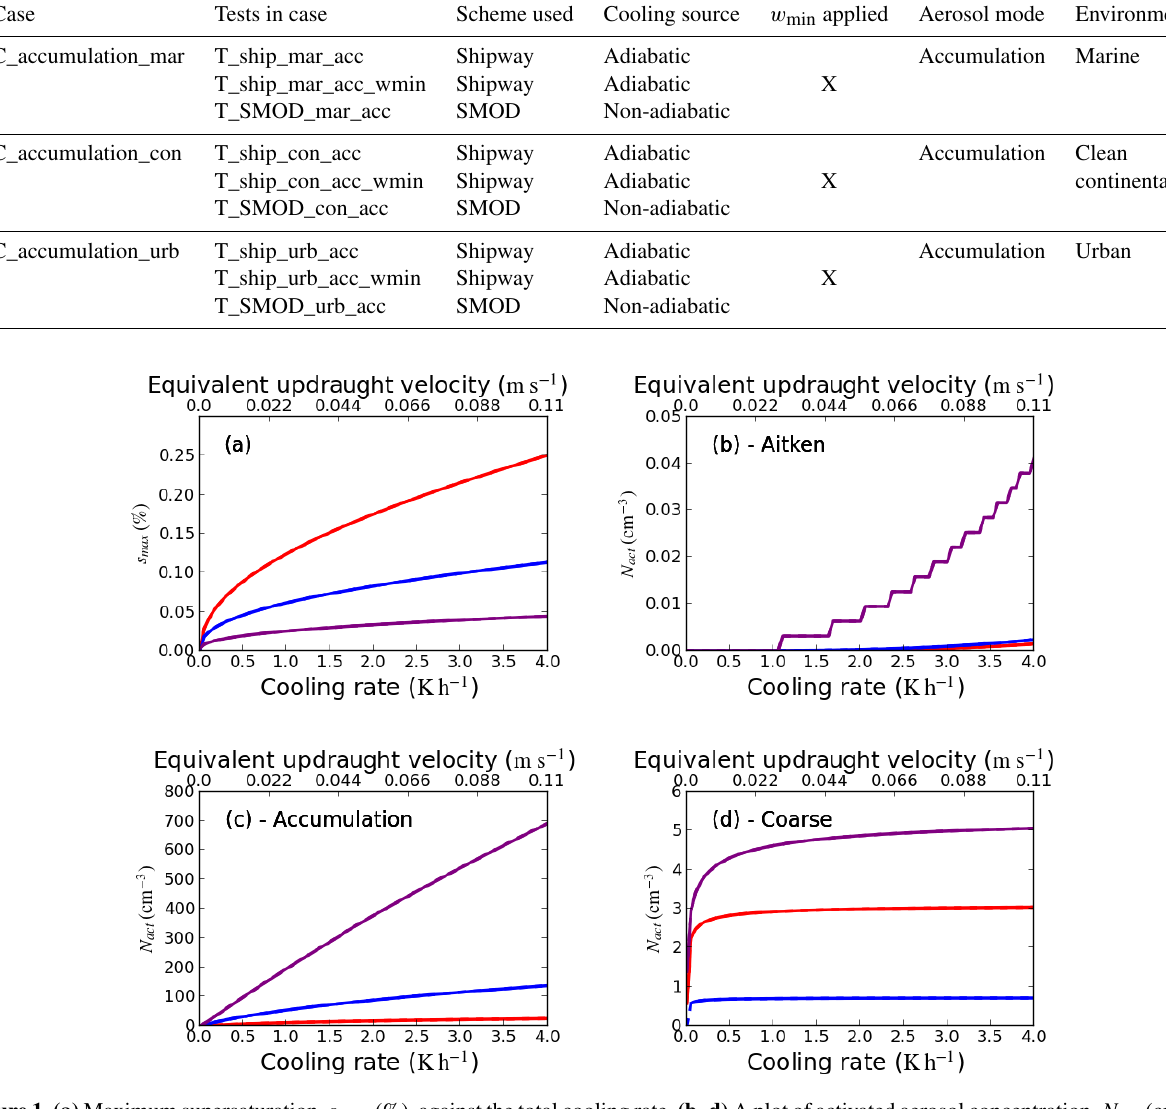
Figure 1. (a) Maximum supersaturation, s max (%), against the total cooling rate. (b–d) A plot of activated aerosol concentration, N act (cm − 3 ), against the total cooling rate for Aitken-, accumulation- and coarse-mode aerosols respectively. Red – marine; blue – clean continental; purple – urban. Solid line – T_ship_ad; dashed line – T_SMOD_ad (solid line overlying the dashed